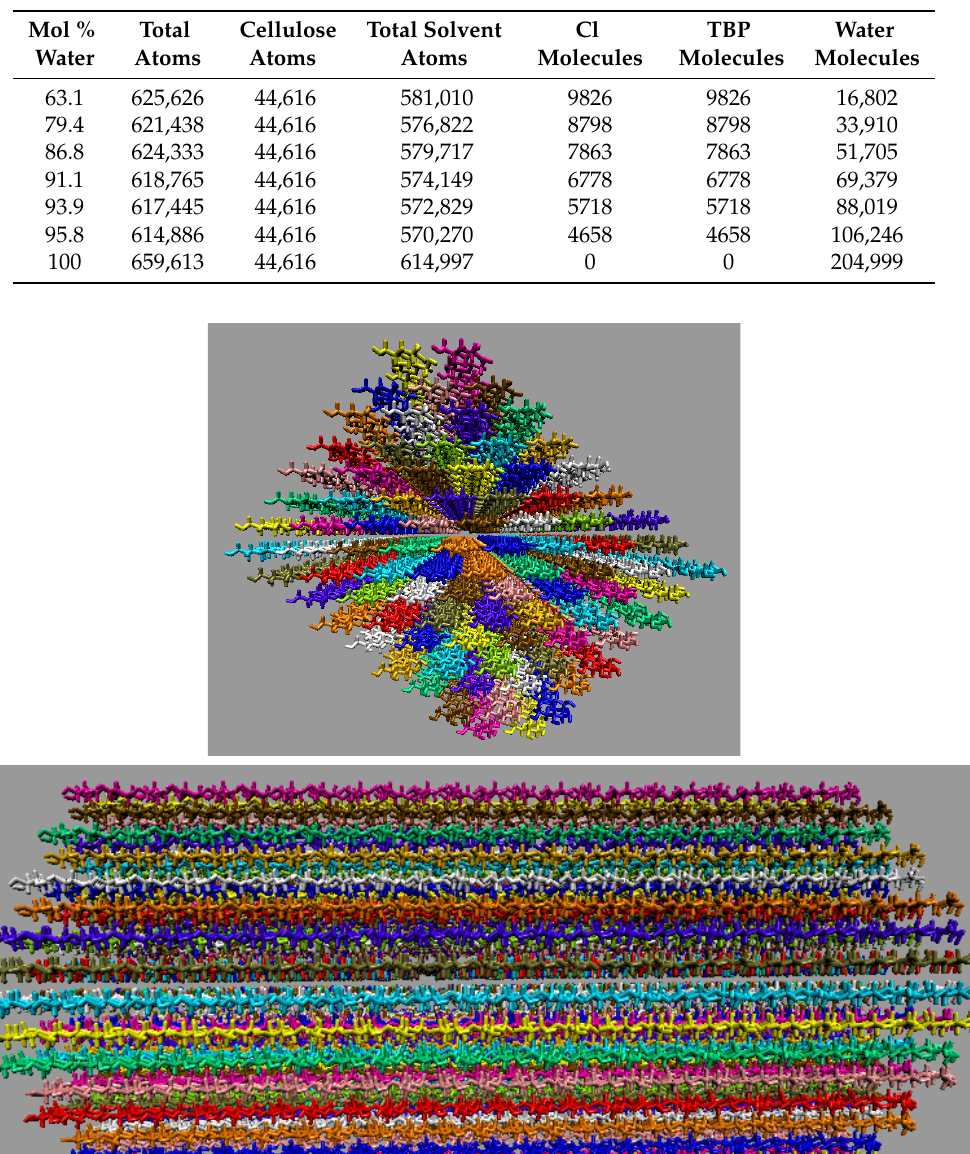
Table 2. Large cellulose bundle (88 strands) simulation compositions.